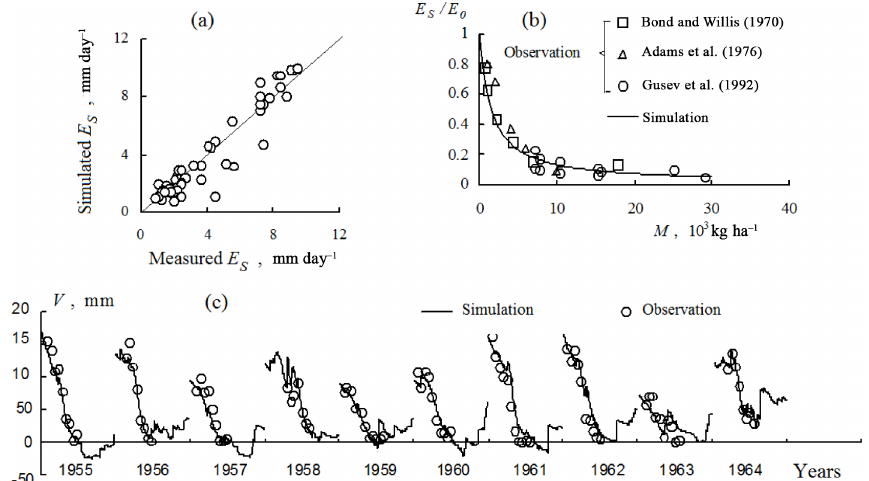
Figure 1. Model validation: (a) comparison of simulated daily bare soil evaporation and measured one at the Kursk Biospheric station (solid line is the 1:1 line); (b) cumulative (for some rainless intervals) evaporation from bare soil covered with straw mulch vs. surface density of straw M ( E 0 is the potential bare soil evaporation without mulch cover); (c) dynamics of simulated and measured productive water storage V in 1m soil layer during the warm seasons (from April to October) in wheat fields at the Ershov agrometeorological